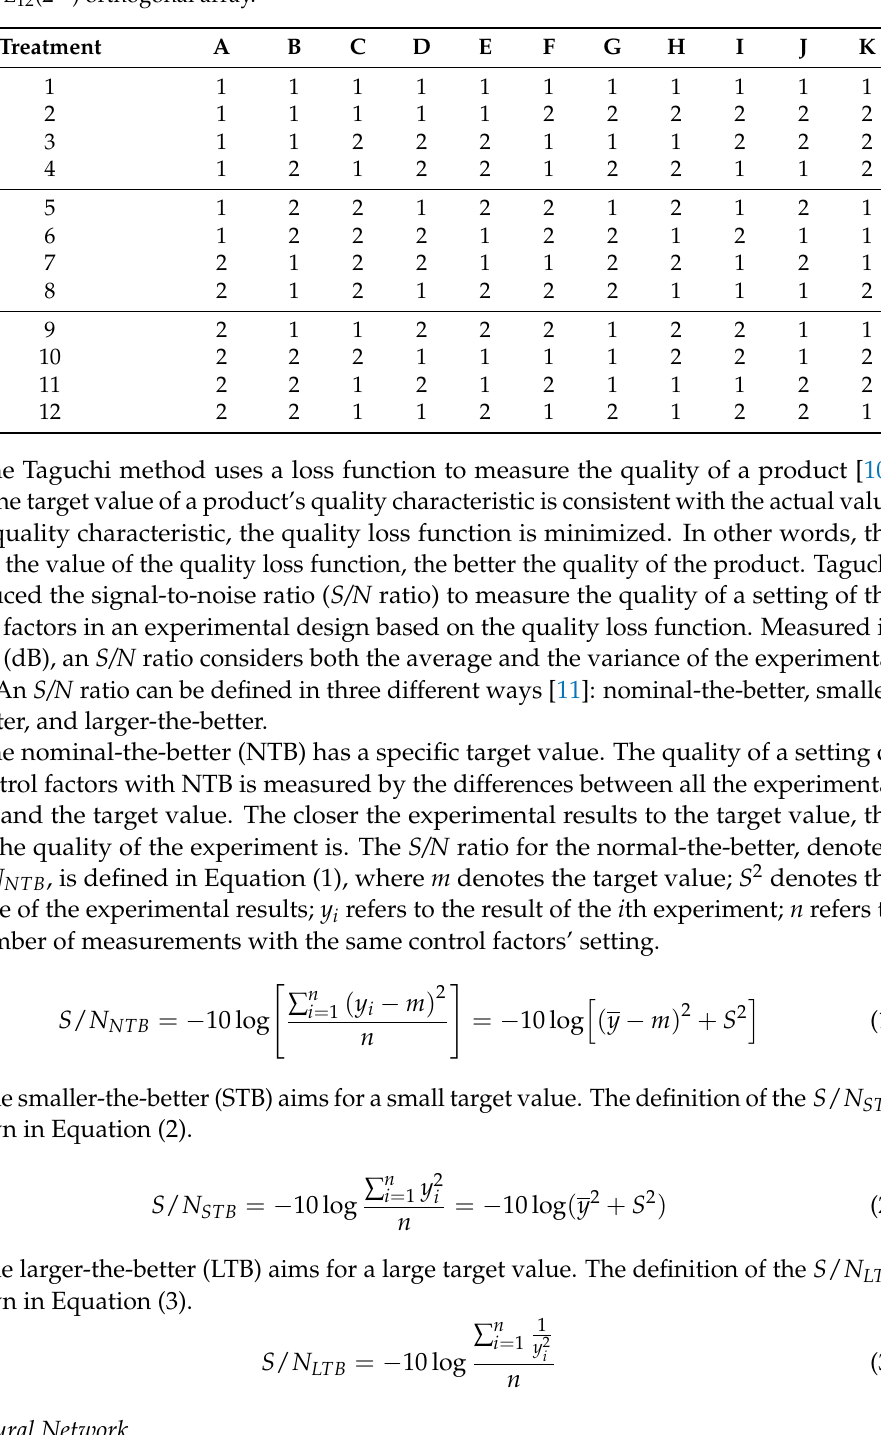
Table 1. L 12 (2 11 ) orthogonal